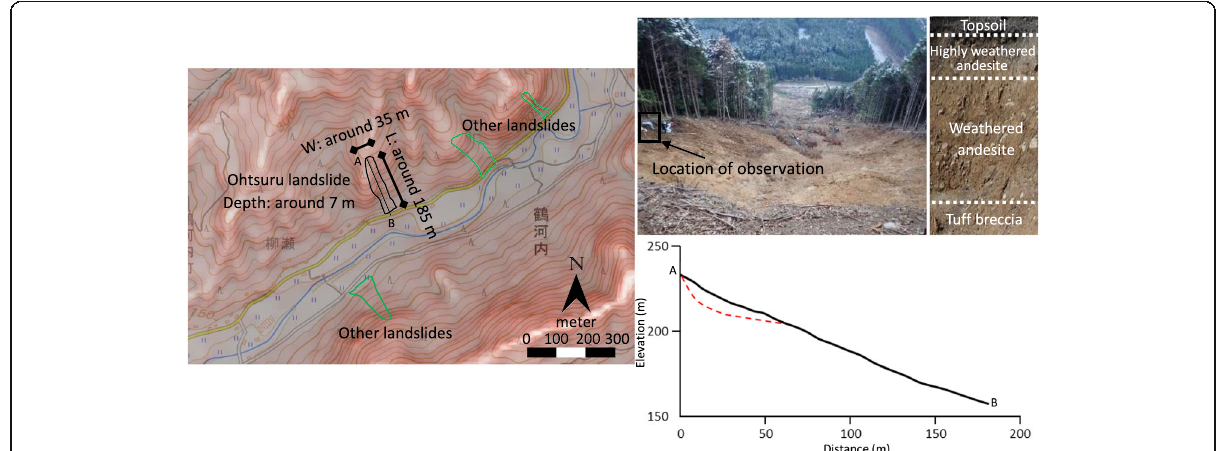
Fig. 4 Topographic map (Geospatial Information Authority of Japan 2020) with cross-section and photos of Ohtsuru landslide (taken on July